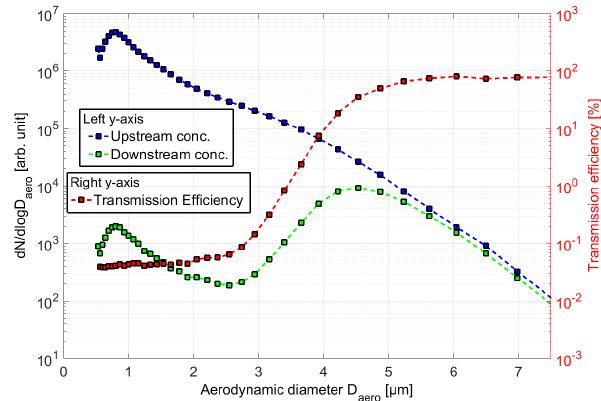
Figure 9. Transmission efficiency of the BMI PCVI, with flows of 7Lmin − 1 (sample flow), 8.3Lmin − 1 (pump flow), 2.3Lmin − 1 (add flow) and 1Lmin − 1 (outlet flow), as measured by a TSI model 3321 Aerodynamic Particle